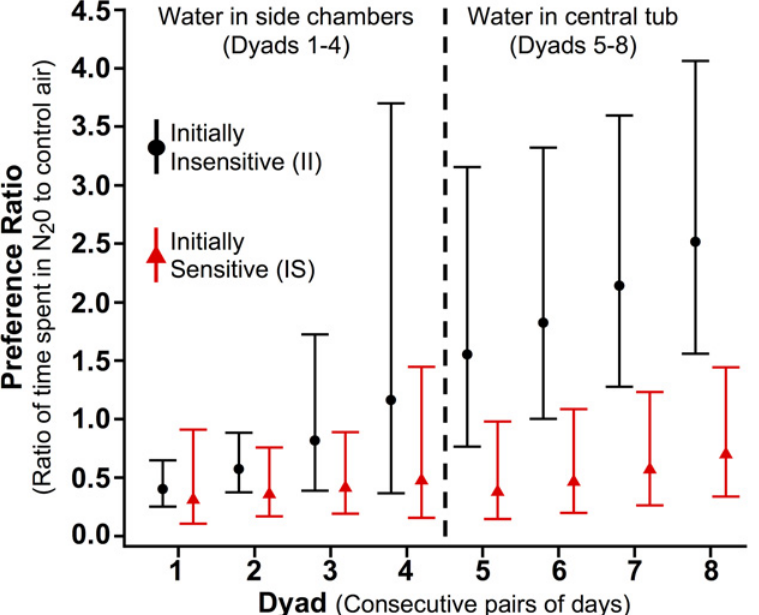
2 O preference ratio is the ratio of time each rat spent in the N 2 O chamber versus the control air chamber during each dyad, and was compared between initially insensitive (II, black circles) and initially sensitive (IS, red triangles) rats using linear modeling applied to log-transformed ratios. Points represent geometric means and error bars are pointwise 95% confidence intervals. Ratio comparisons were